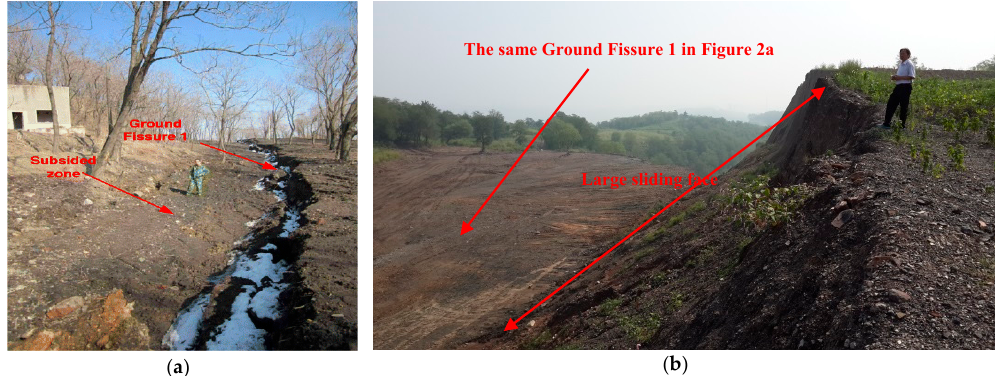
Figure 2. ( a ) A picture of ground fissure at the Qiantai Mountain peak on 16 March 2013 quoted from